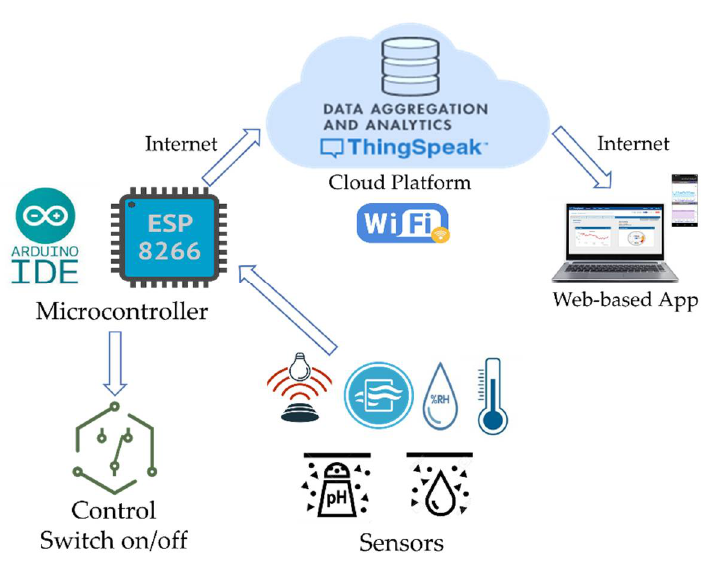
Figure 2. An overview of the IoT-based control and monitoring system for the ex vitro acclimatization system (E-VAS).